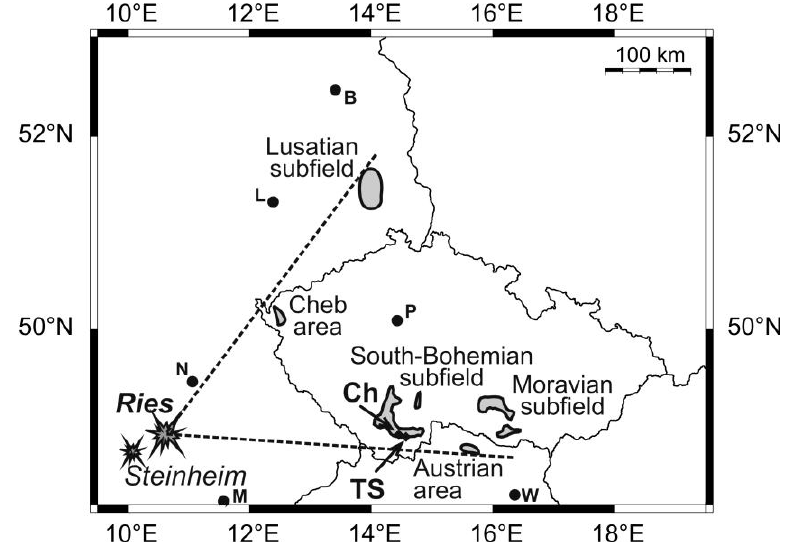
Figure 1. Map showing the extent of known moldavite occurrences (grey shading) and the location of the studied moldavites: Ch = Chlum; TS = Trhové Sviny. Also shown are the impact craters Ries and Steinheim. (P = Prague, M = Munich, N = Nuremberg, L = Leipzig, B = Berlin and W =